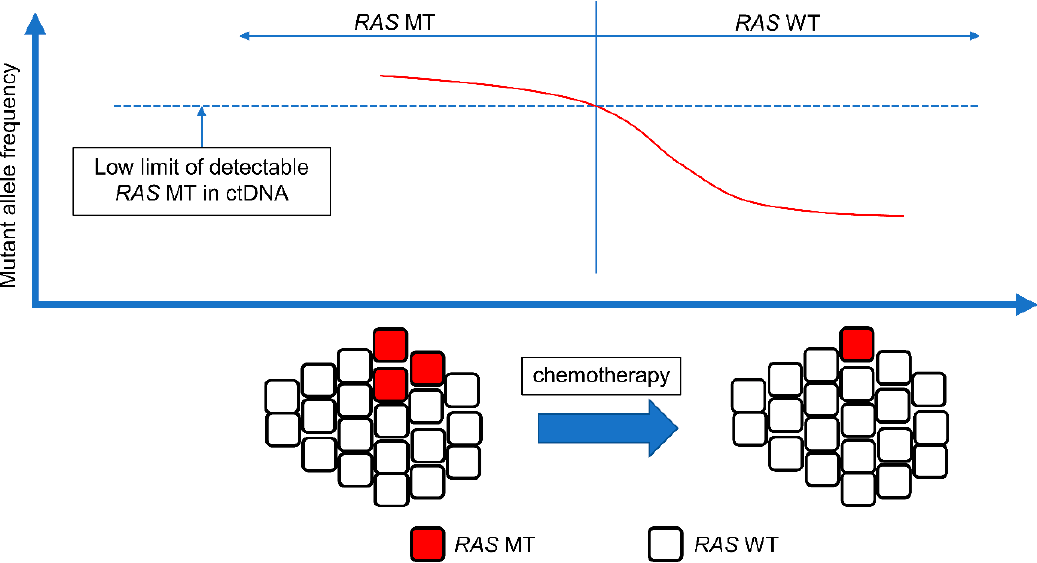
Figure 2. Concept of Neo RAS WT. The presence of tumor cells with low RAS allele frequency close to the cutoff level. The mutant allele frequency of RAS is below the detection threshold after the treatment, resulting in Neo RAS WT mCRC. mCRC, metastatic colorectal cancer; ctDNA, circulating tumor DNA; MT, mutant; WT, wild-type.